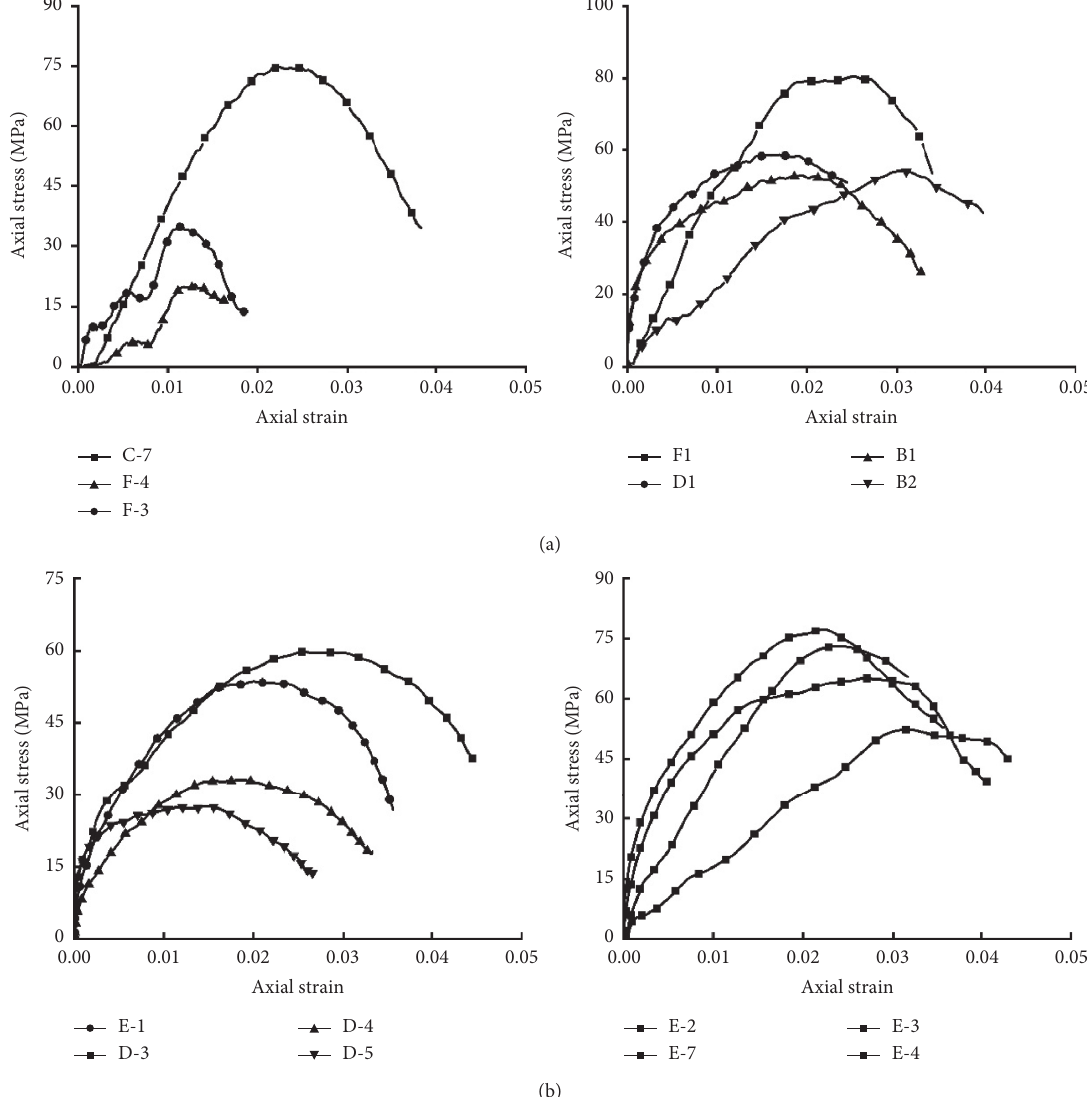
Figure 8: Stress-strain curve: dynamic compressive testing. (a) A static axial prestress of 0 MPa. (b) A static axial prestress of